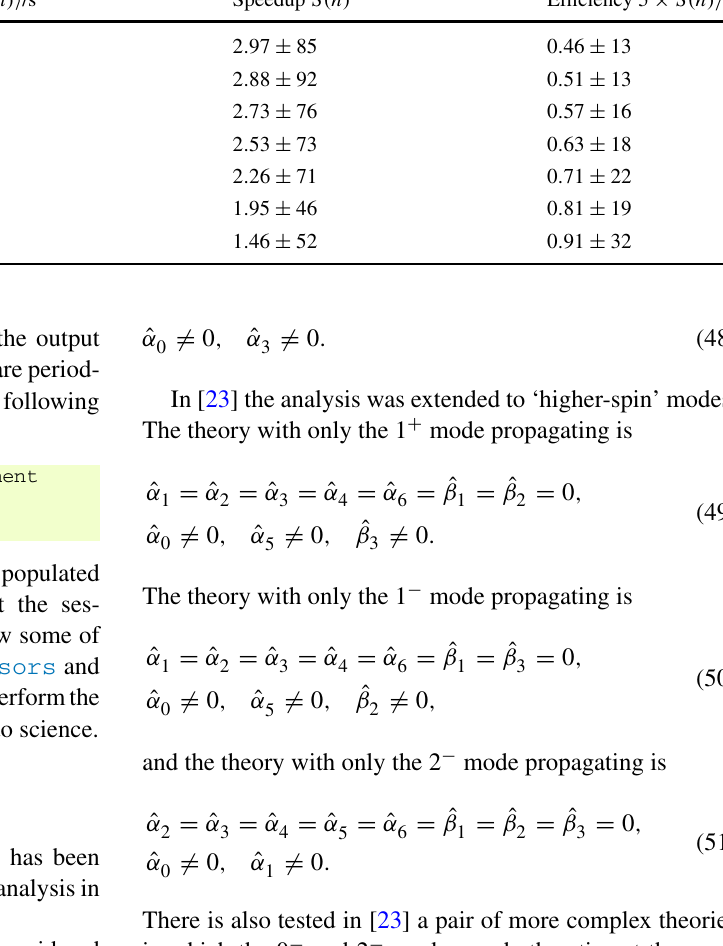
clock time (cid:12) t ( n ) (cid:13) is averaged over all 14 nodes, but apparent σ